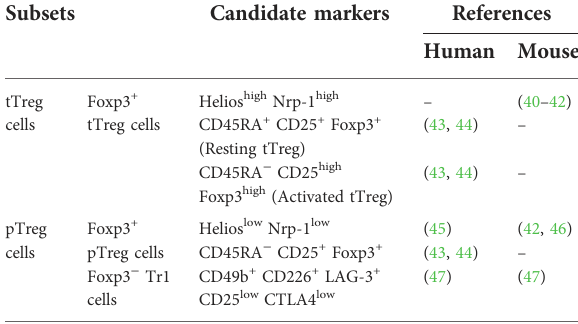
TABLE 1 CD4 + regulatory T (Treg)